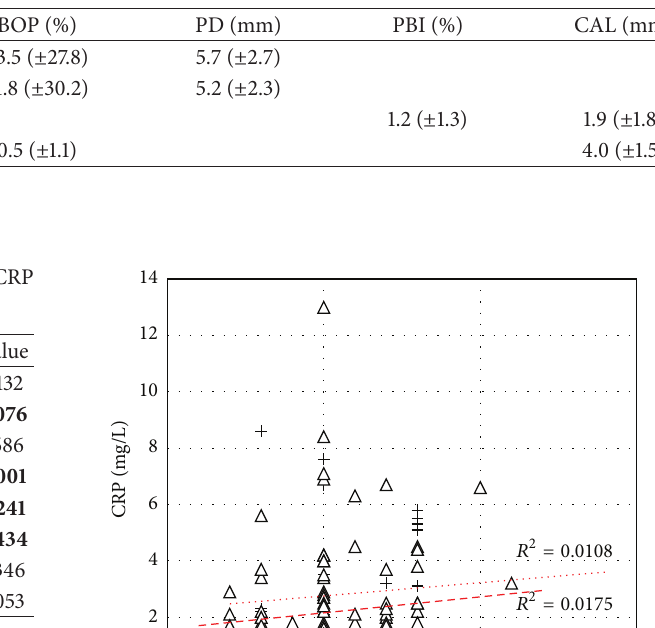
Table 2: Levels of CRP and clinical parameters in all tested groups.